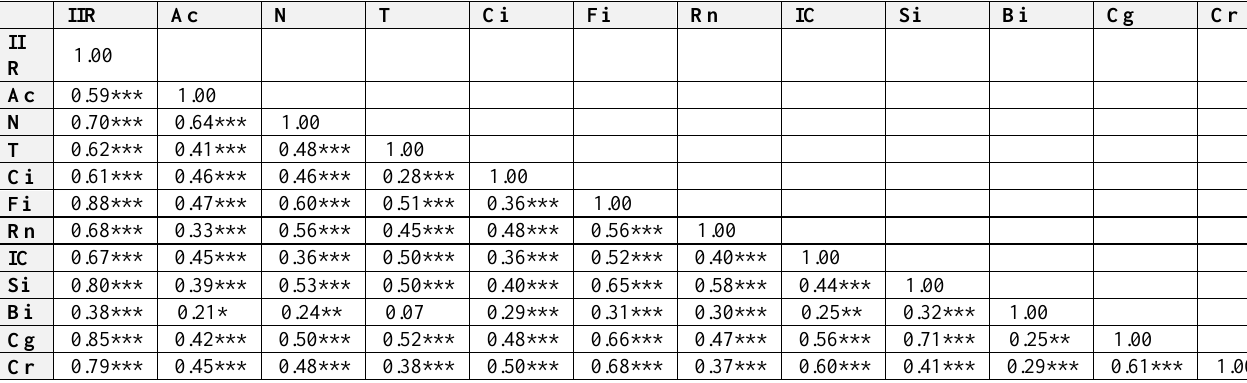
Table 4: Correlation matrix: measurement instrument